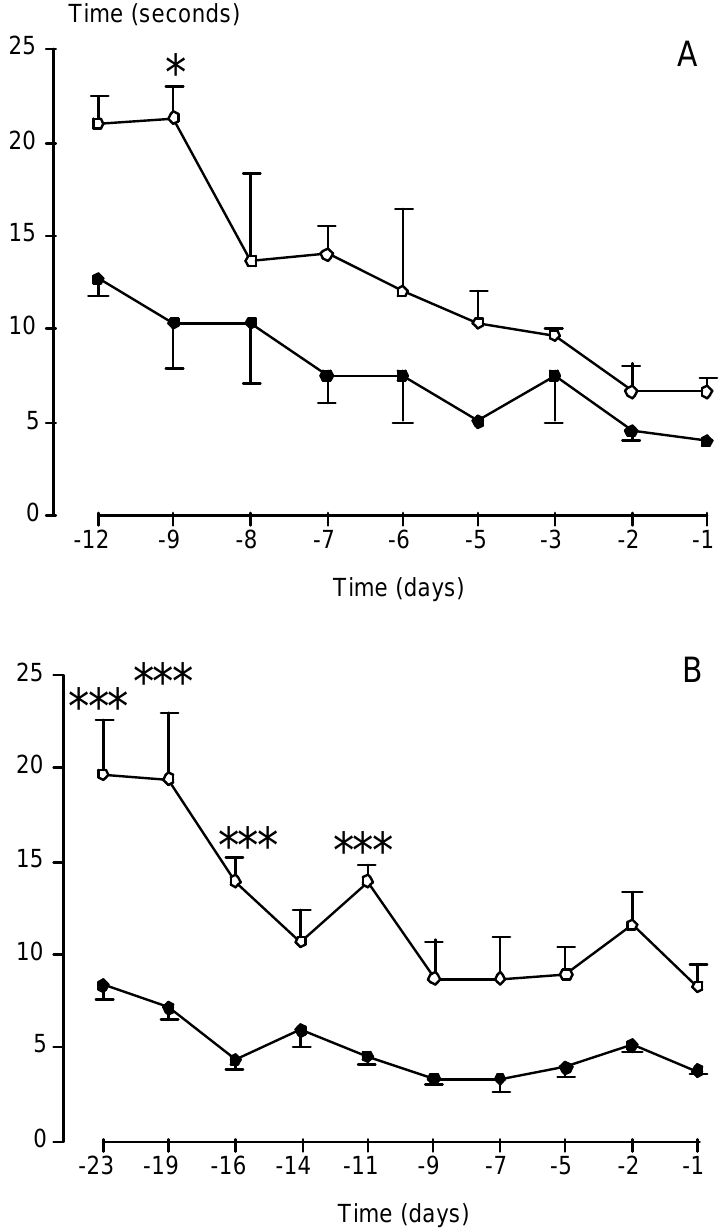
Figure 10. Effect of 4m-CFA (n=14) (A), and t-CFA (n=15) (B) on the ability of mice to perform an exercise. The mice used in these experiments overexpress a mutant Cu/Zn superoxide dismutase gene associated with the neurodegenerative disease amyotrophic lateral sclerosis. The task consisted in determining the time (in seconds) necessary to cross a metallic bar of 45 cm long. Substances were injected intraperitoneally at 8 mg/kg 4m-CFA (n=14) or 32 mg/kg t-CFA (n=15) three times per week during 50-60 days, and meaurements were taken at days indicated in the abscissas before disease onset and death of the animals through motor paralysis. Note that treated mice (filled circles in both graphs) are more active than control animals. * p <0.05, *** p <0.001 vs corresponding control; one-way ANOVA, followed by Student-Newman-Keuls